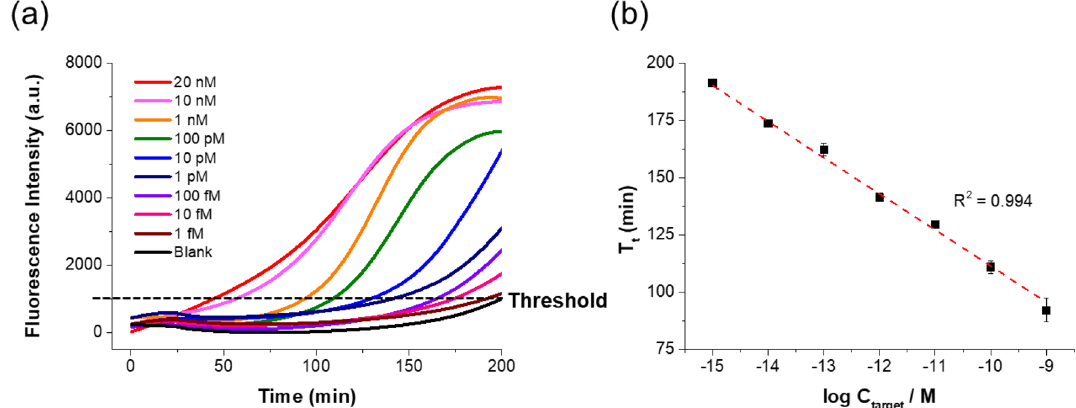
Figure 3. Sensitivity of the PHAmp reaction. ( a ) Time-dependent fluorescence intensities (via SYBR Green I staining) during the PHAmp reaction with target DNA at various concentrations. ( b ) Linear relationship between Tt and the logarithm of the target DNA concentration in the range from 1fM to 1 nM, where Tt is defined as the time at which the fluorescence signal reaches the threshold intensity (1000 a.u.) and C target is the target DNA concentration. The error bars represent the standard deviations of three replicate